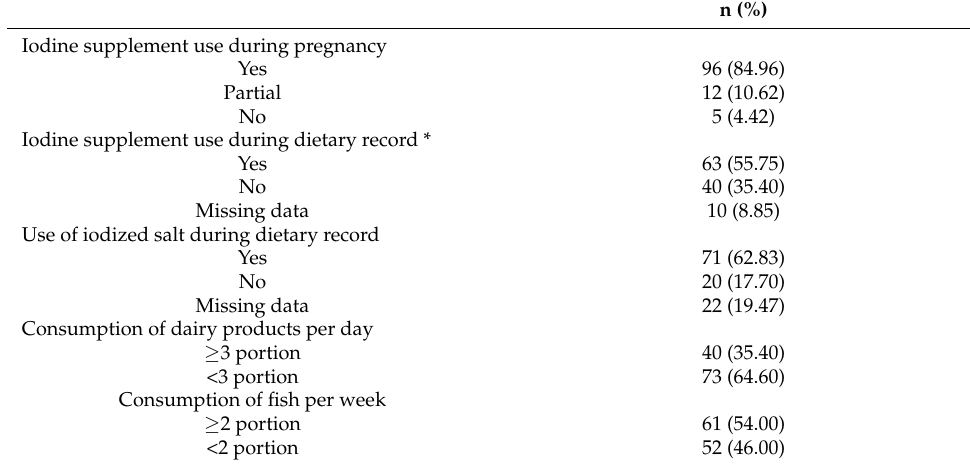
Table 4. Iodine-related characteristics of human milk donors (n = 113).